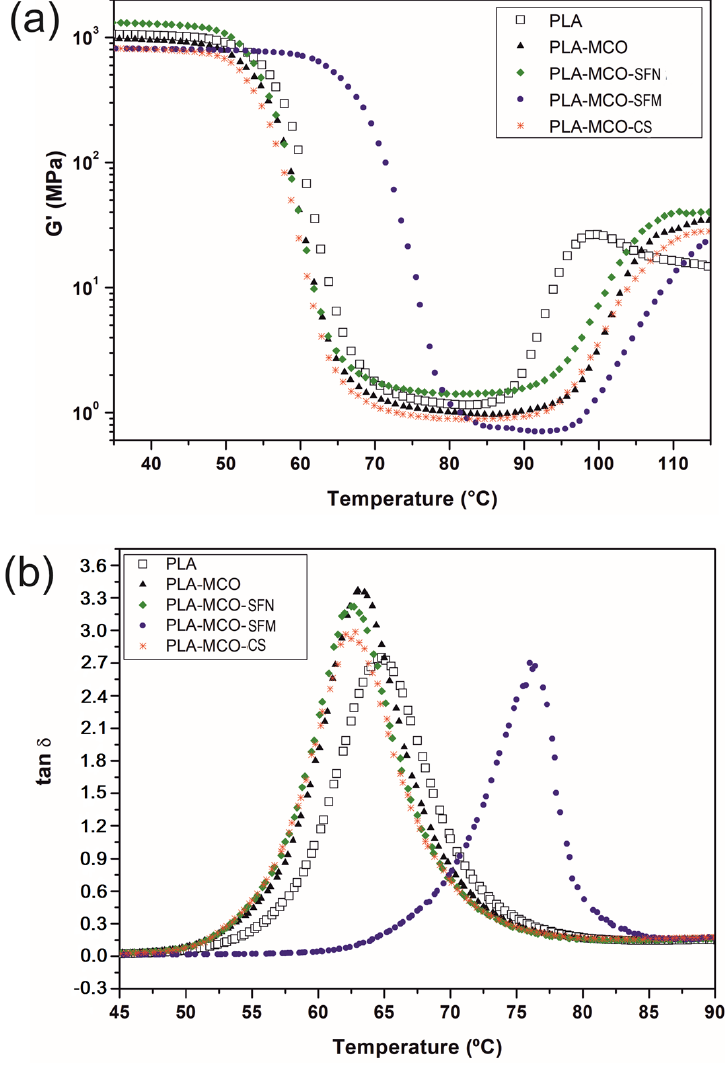
Figure 5. Effect of the temperature on the storage modulus (G ′ ) ( a ) and damping factor ( tan δ ) ( b ) of neat PLA, plasticized PLA, and PLA-Silk